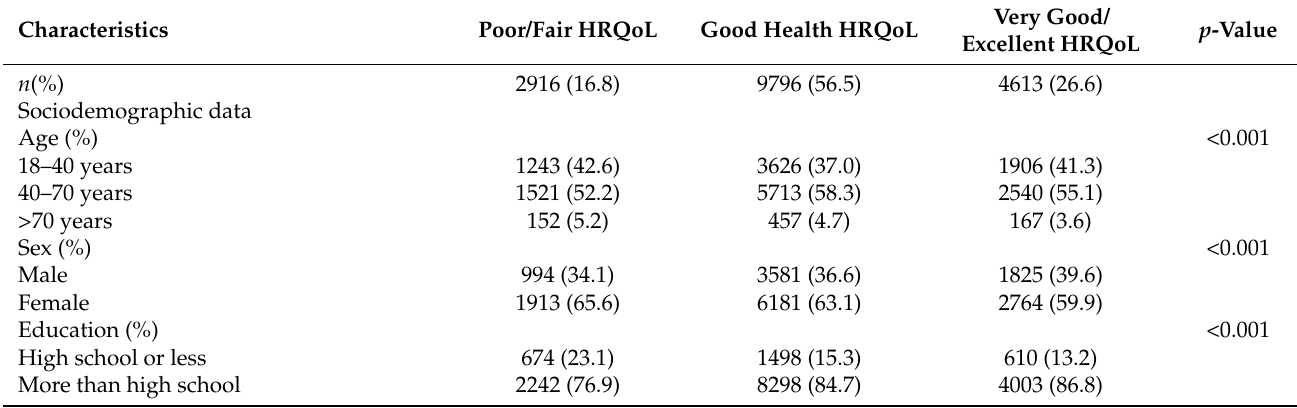
Table 4. Sociodemographic Data, Health Characteristics, Dietary Habits, Lifestyle and Quality of Life Features of the participants Categorized by Item 1 of the SF-12 Health Survey (“In general, would you say your health